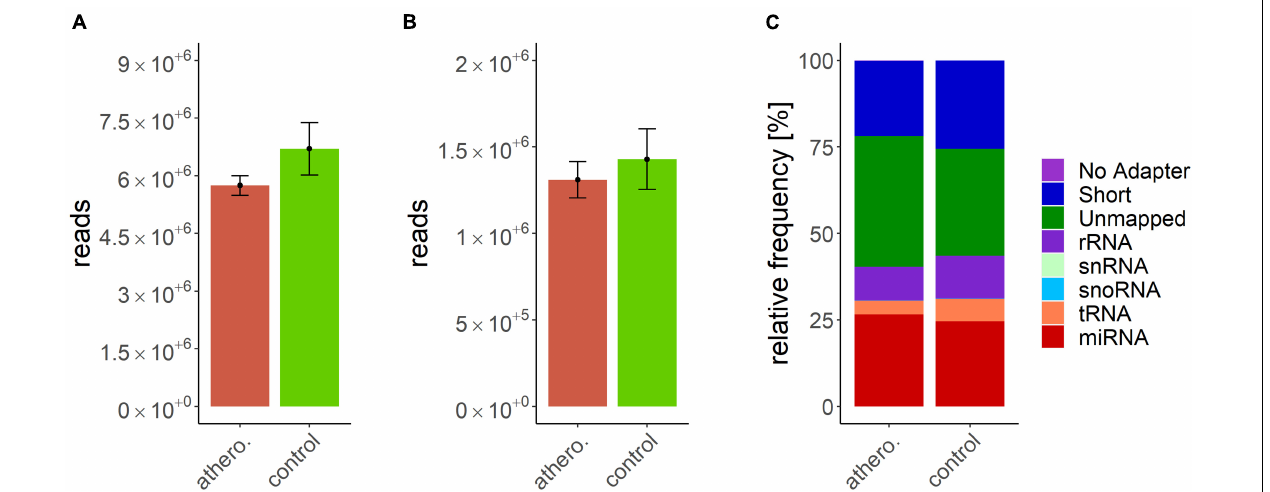
FIGURE 1 | (A) mean library size: athero: 5.74 ± 0.25 M.; control: 6.7 ± 0.69 M.; (B) mean of mapped miRNAs: athero: 1.31 ± 0.11 M.; controlr: 1.43 ± 0.17 M.; (C) mean relative frequency of mapped read counts. athero = atherosclerotic group; control = control group; No Adapter = reads without adapter; Short = reads smaller than 16 nt; Unmapped = reads which are not mapped to reference; rRNA = reads mapped as rRNA; snRNA = reads mapped as snRNA; snoRNA = reads mapped as snoRNA; tRNA = reads mapped as tRNA; miRNA = reads mapped as miRNA.